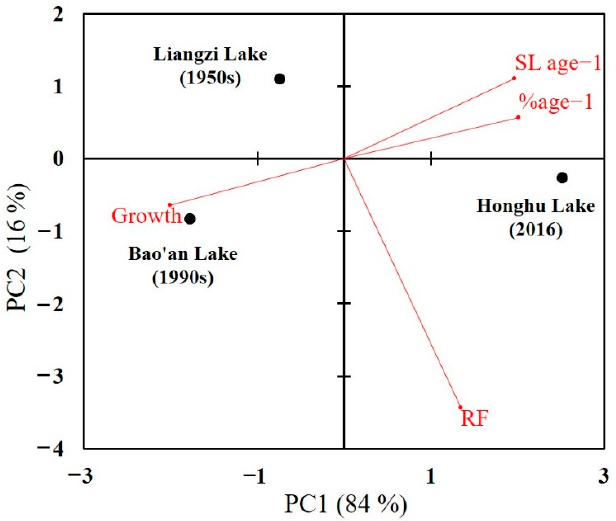
Figure 4. Temporal changes in the life-histories of Odontobutis sinensis in the middle Yangtze River as revealed through PCA. Increasing PC1 values correspond with increasing size at age-1, percent of fish mature at age-1, and decreased growth. PC2 values denote changes to the relative fecundity of fish (Table 1). Thus modern fish in Honghu Lake are larger, faster-growing, have increased fecundities, and have a high percent of sexually mature individuals.